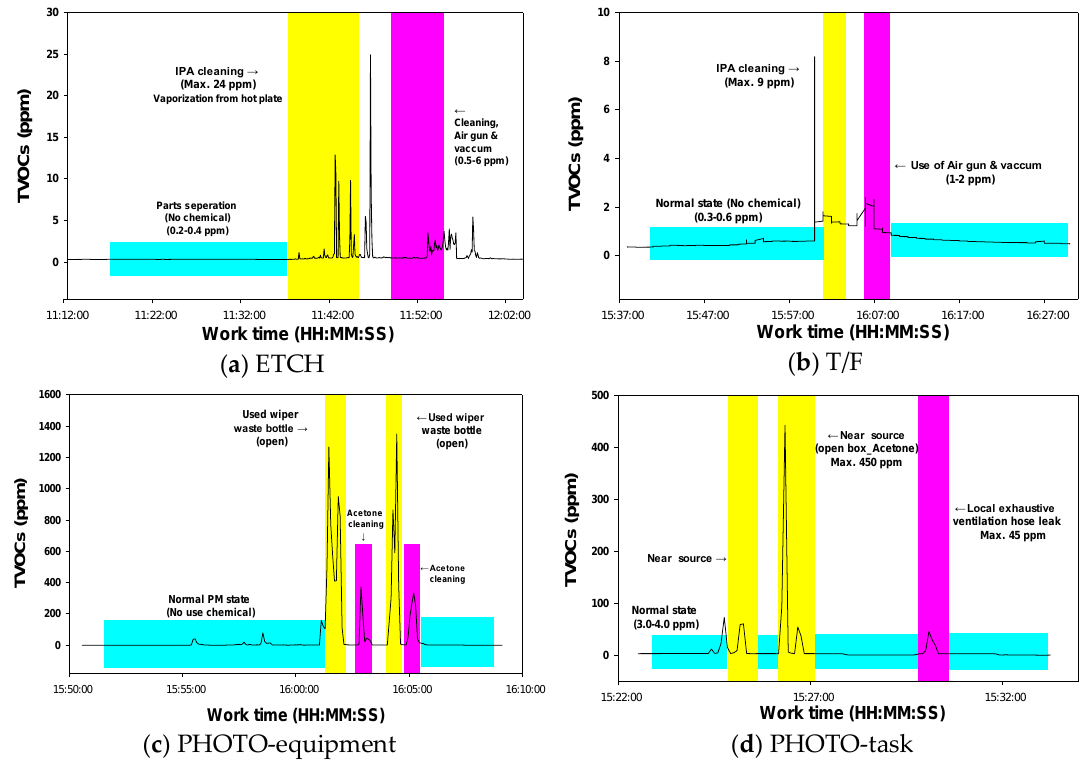
Figure 2. Representative examples of high total volatile organic compound (TVOC) concentrations during maintenance tasks in fabrication facility. ( a ) isopropyl alcohol (IPA) cleaning in etching process; ( b ) IPA cleaning in thin film process; ( c ) TVOC concentration measured in trashcan where acetone-soaked cloth (after cleaning) was stored among photolithography track equipment; ( d ) acetone cleaning in photolithography track breakdown maintenance task. Table 4. Airborne volatile organic compounds (VOCs) and metal concentrations in package and test processes.